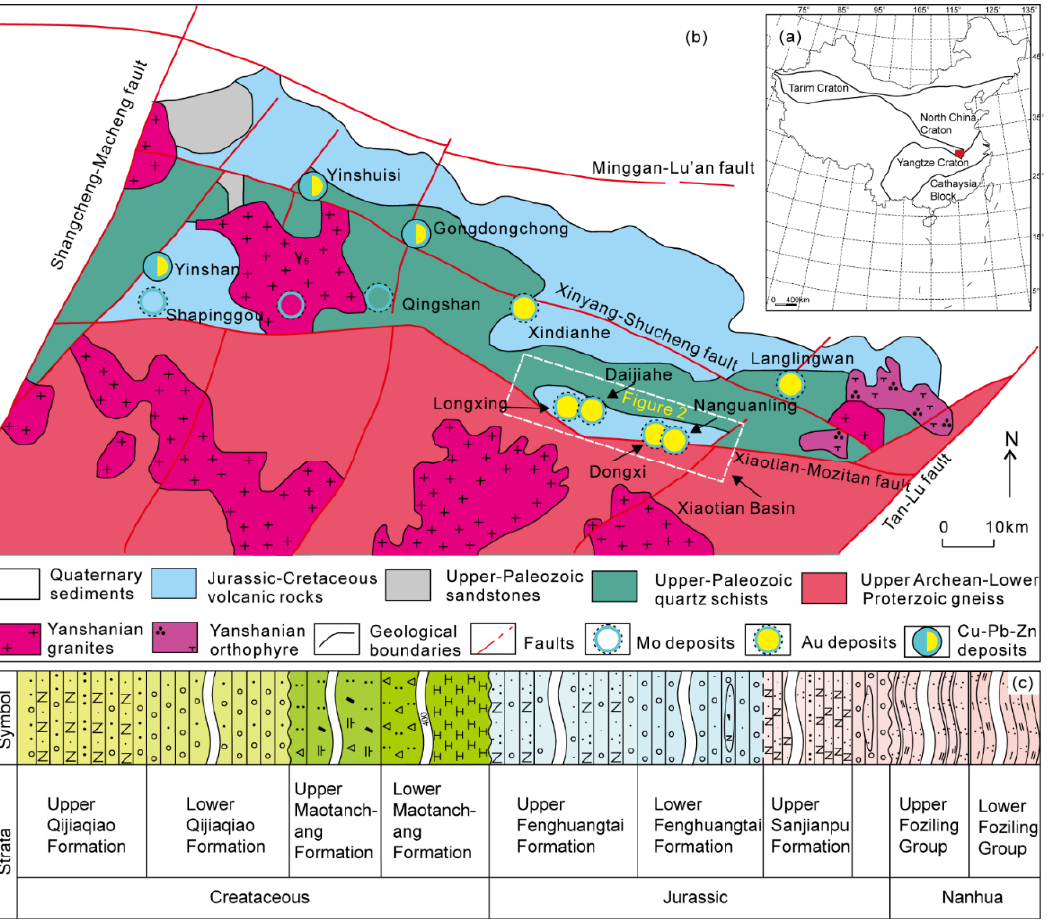
Figure 1. Geological sketch map of China ( a ) and the north Huaiyang Belt ( b ) and the strata sequences of the north Huaiyang Belt ( c ).